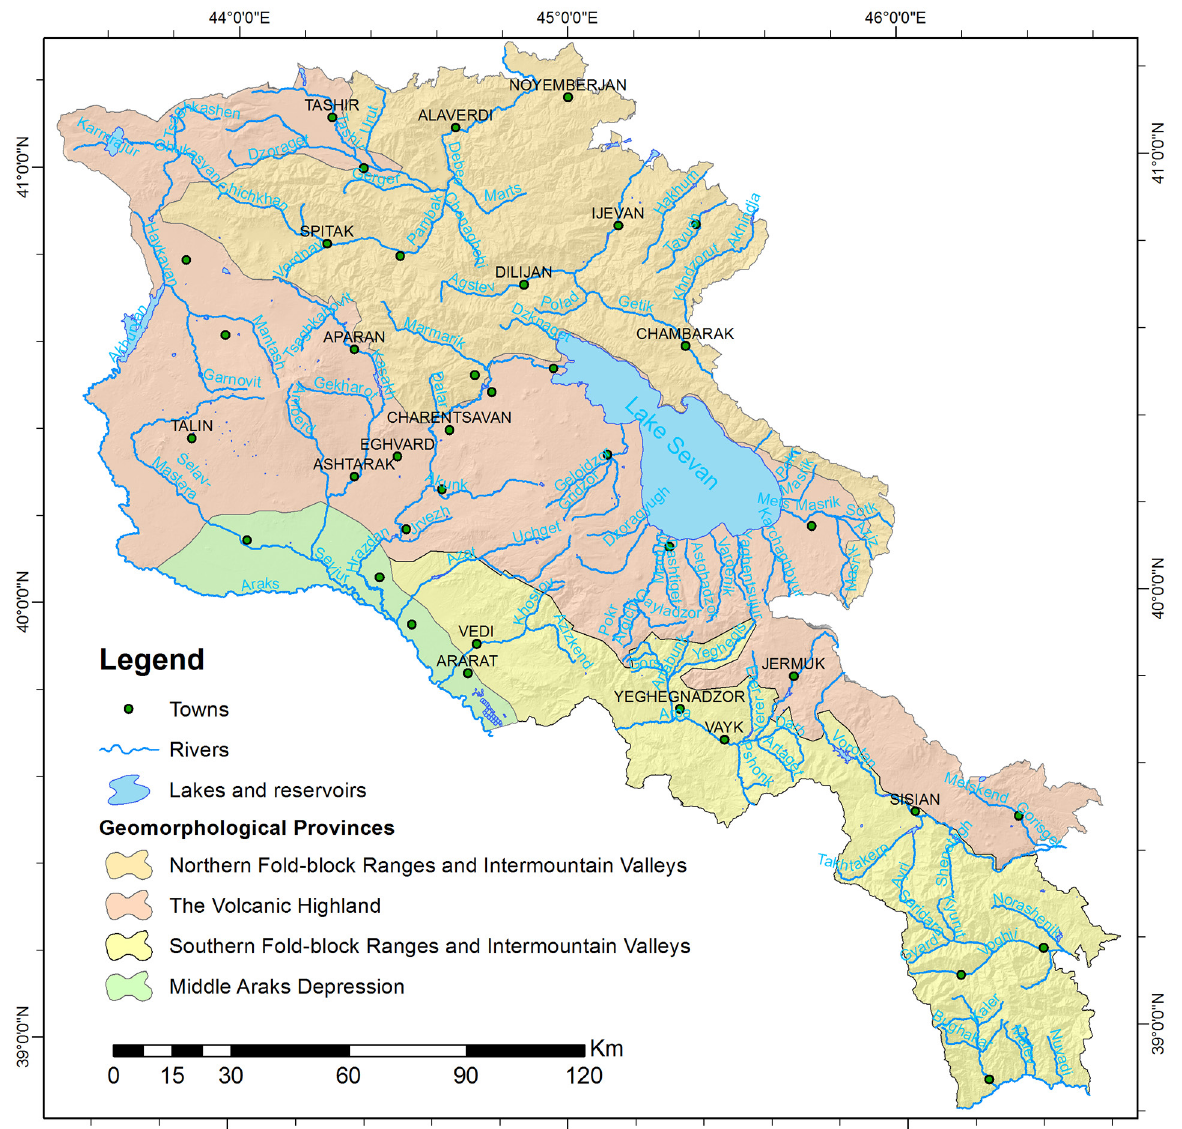
Fig. 1. Map of the geomorphological provinces of